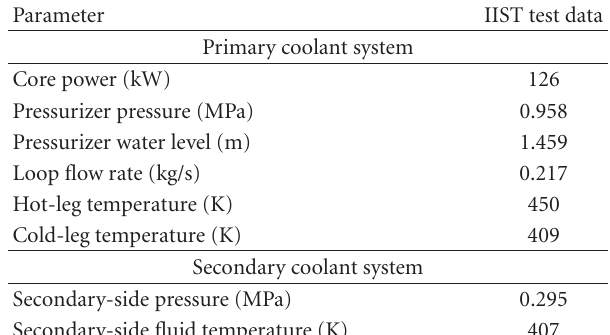
Table 2: The initial condition of the IIST SBLOCA